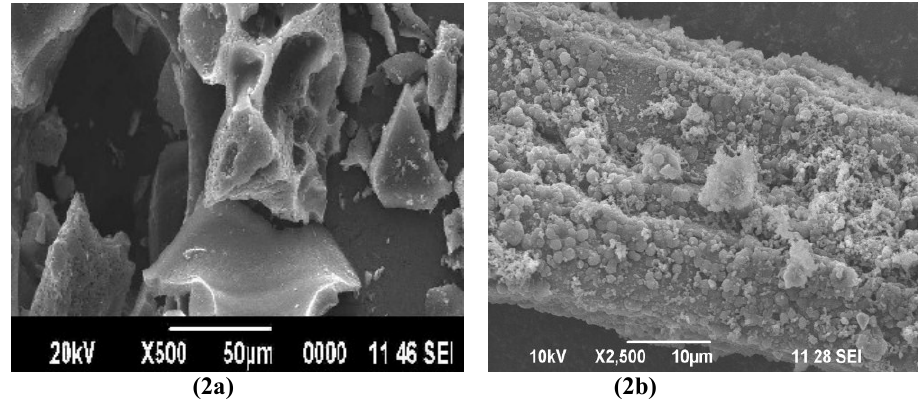
Figure 2. Scanning Electron Micrographs of TPAC and